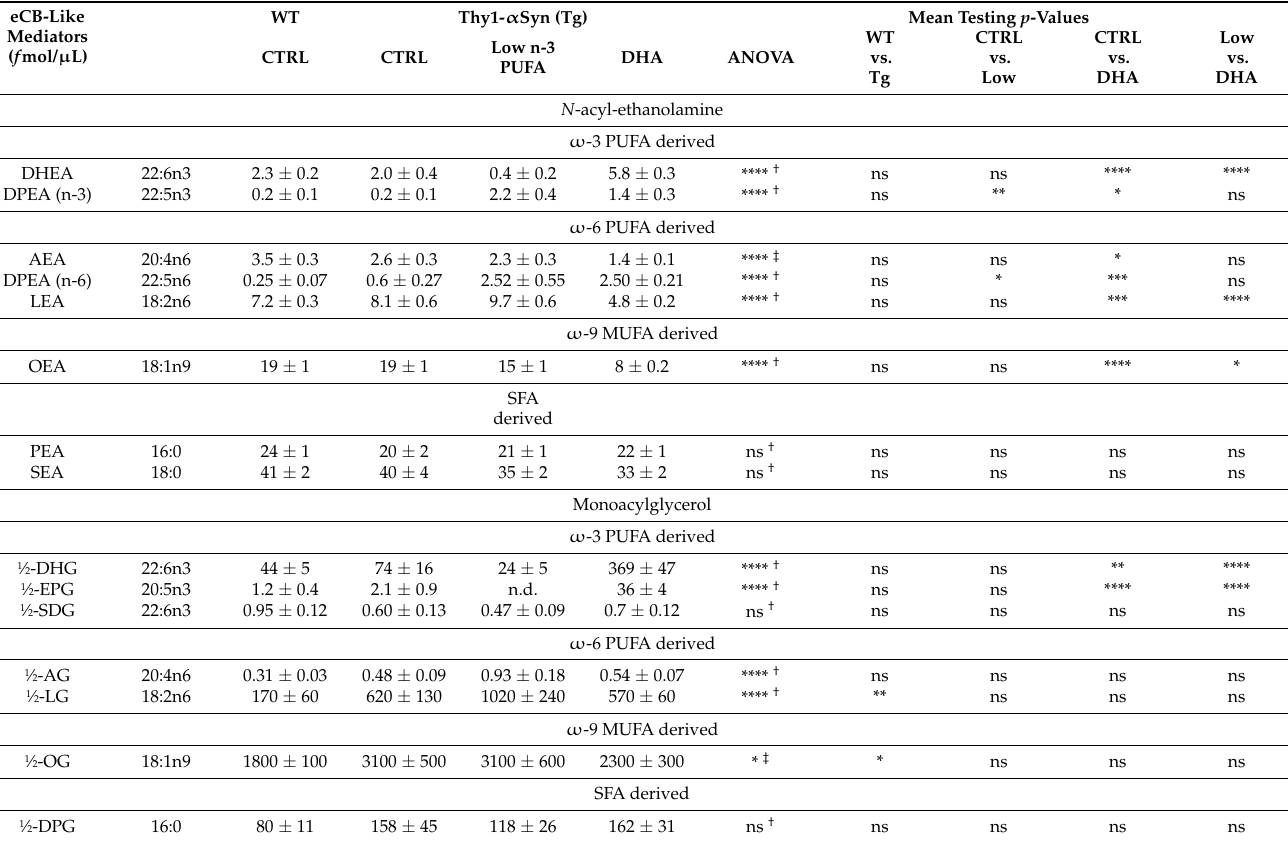
Table 2. Plasma endocannabinoid-like mediators in WT and Thy1- α Syn